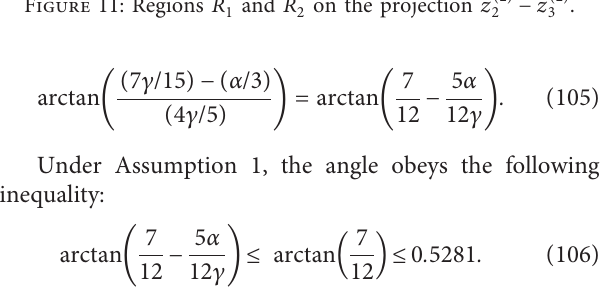
Figure 11: Regions R